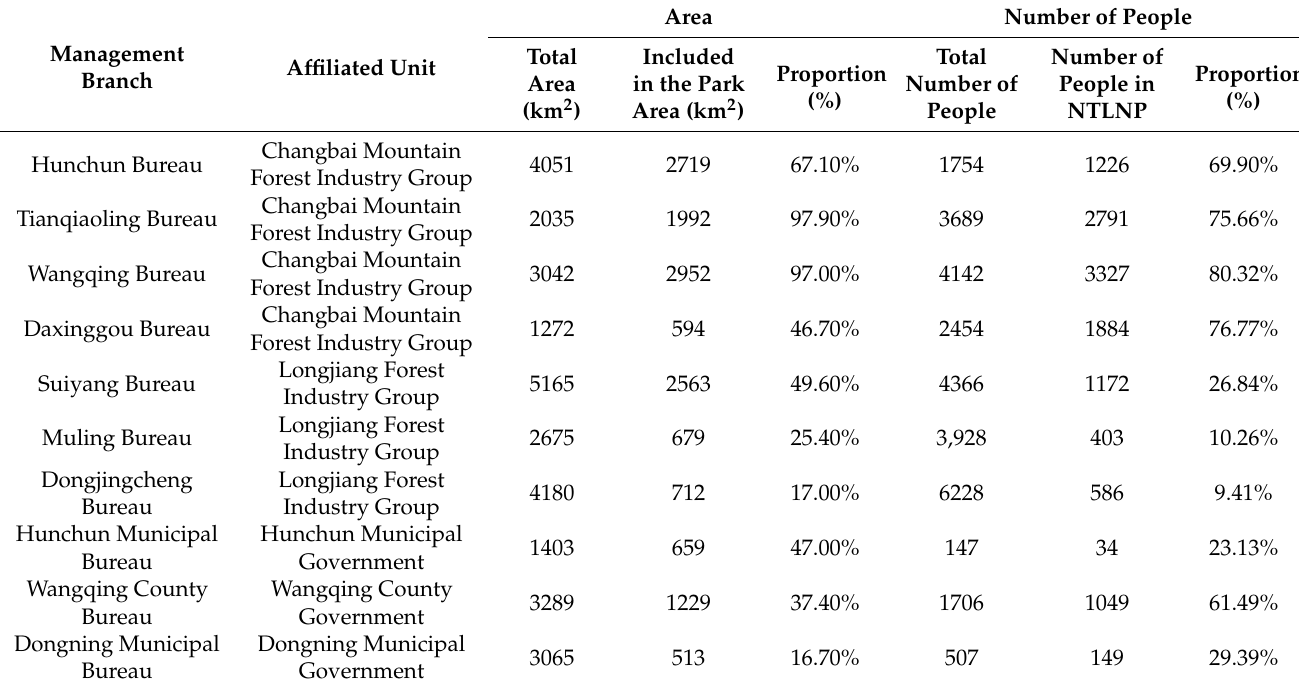
Table 2. The area and number of workers of the management branch included in the